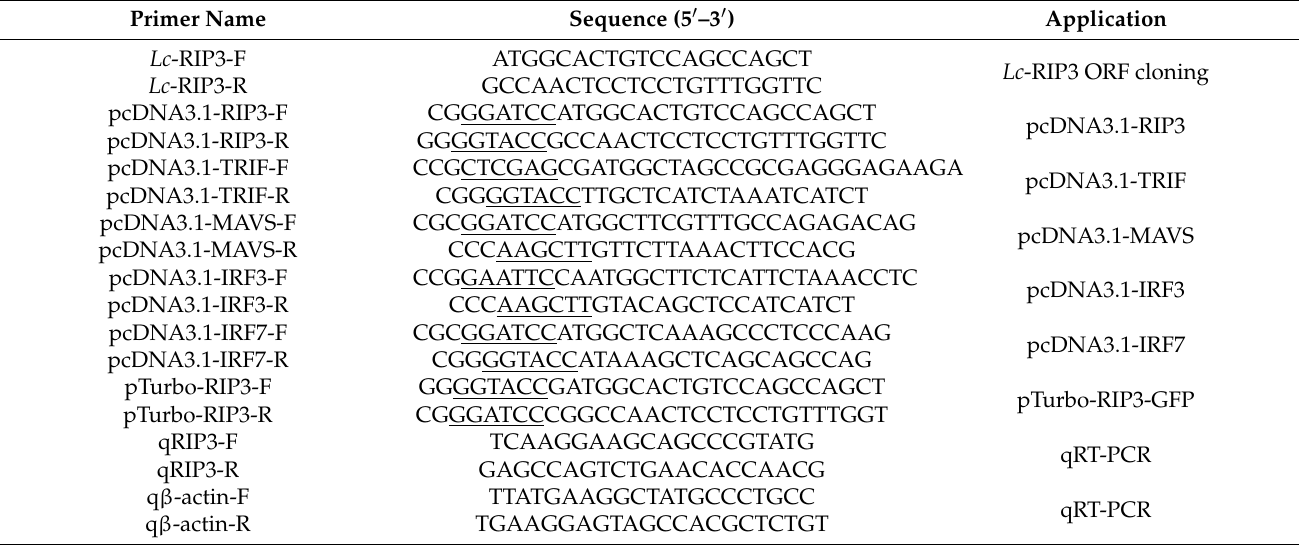
Table 2. Primer sequences used in the present